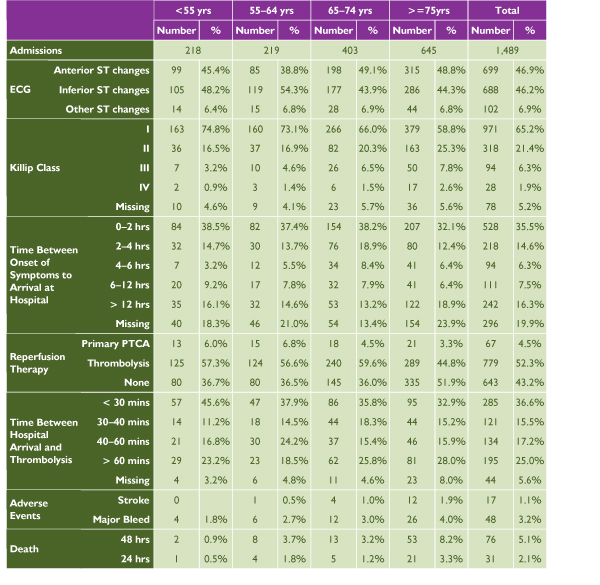
Use of Reperfusion Therapy in Women with ST Elevation Acute Myocardial Infarction in Canada, January 1, 2001 to December 31, 2001 Source: FASTRAK®11 Clinical Registry, 2001